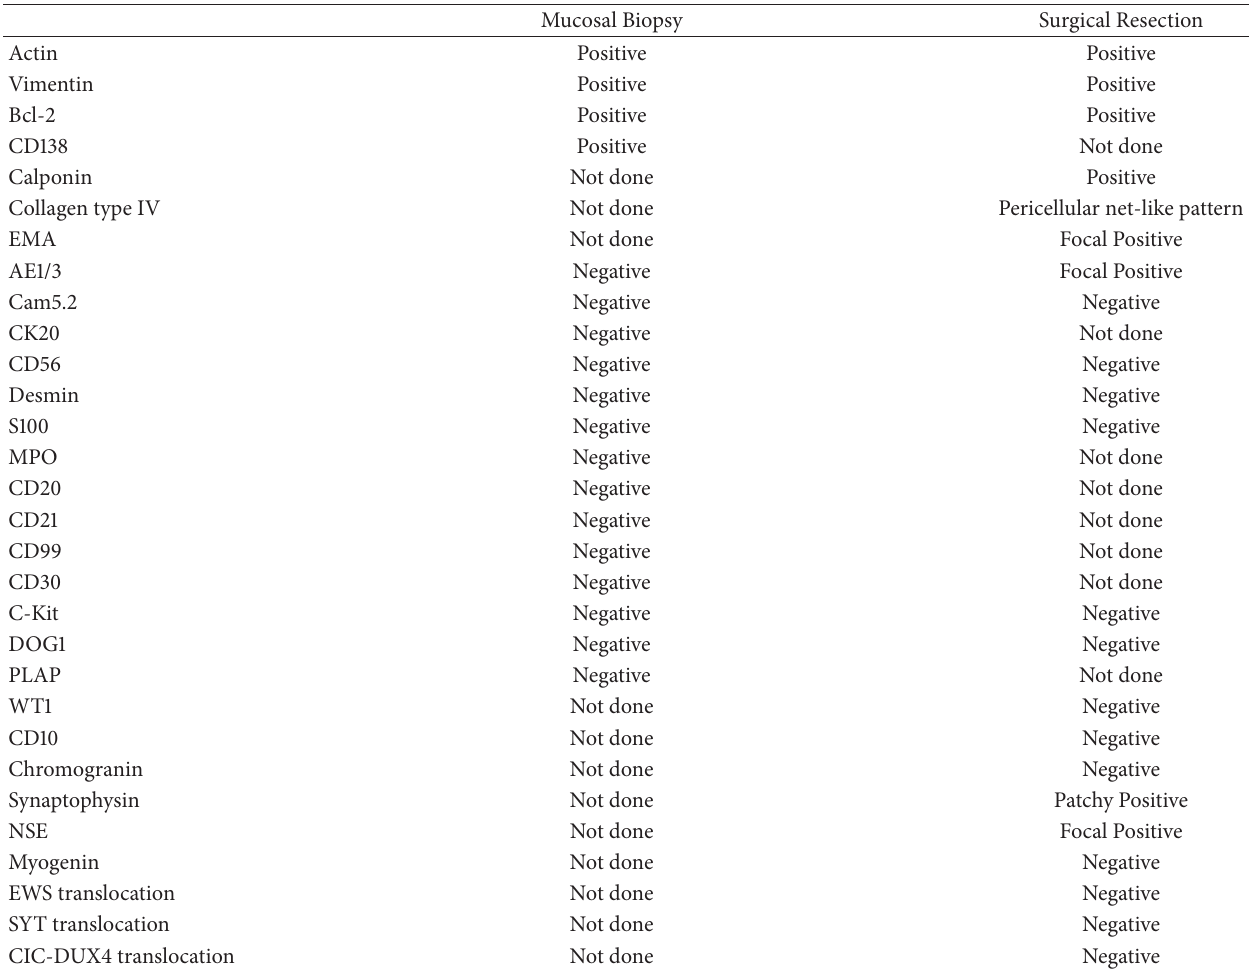
Table 1: Immunohistochemical/FISH results on